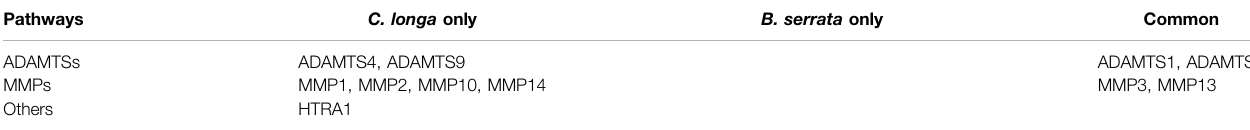
TABLE 2 | Summary of the anti-catabolism main mechanisms of action of C. longa (2 μ g/ml) and B. serrata (50 μ g/ml) extract at 24 h. Pathways